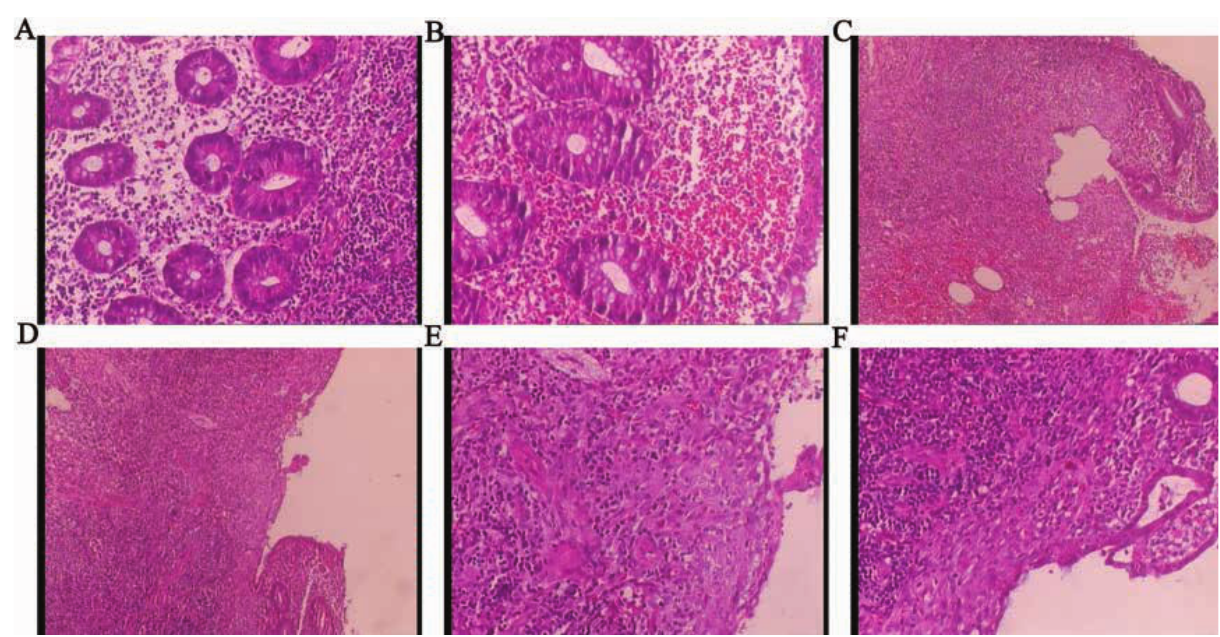
Figure 3: The histology of the appendix after surgery. (A) Inflammatory cells infiltrating. (B) A large number of red blood cells could be seen. (C) Ulcer, inflammatory cells and granulomas were visible. (D-F) Scattered noncaseating granulomas could be seen.